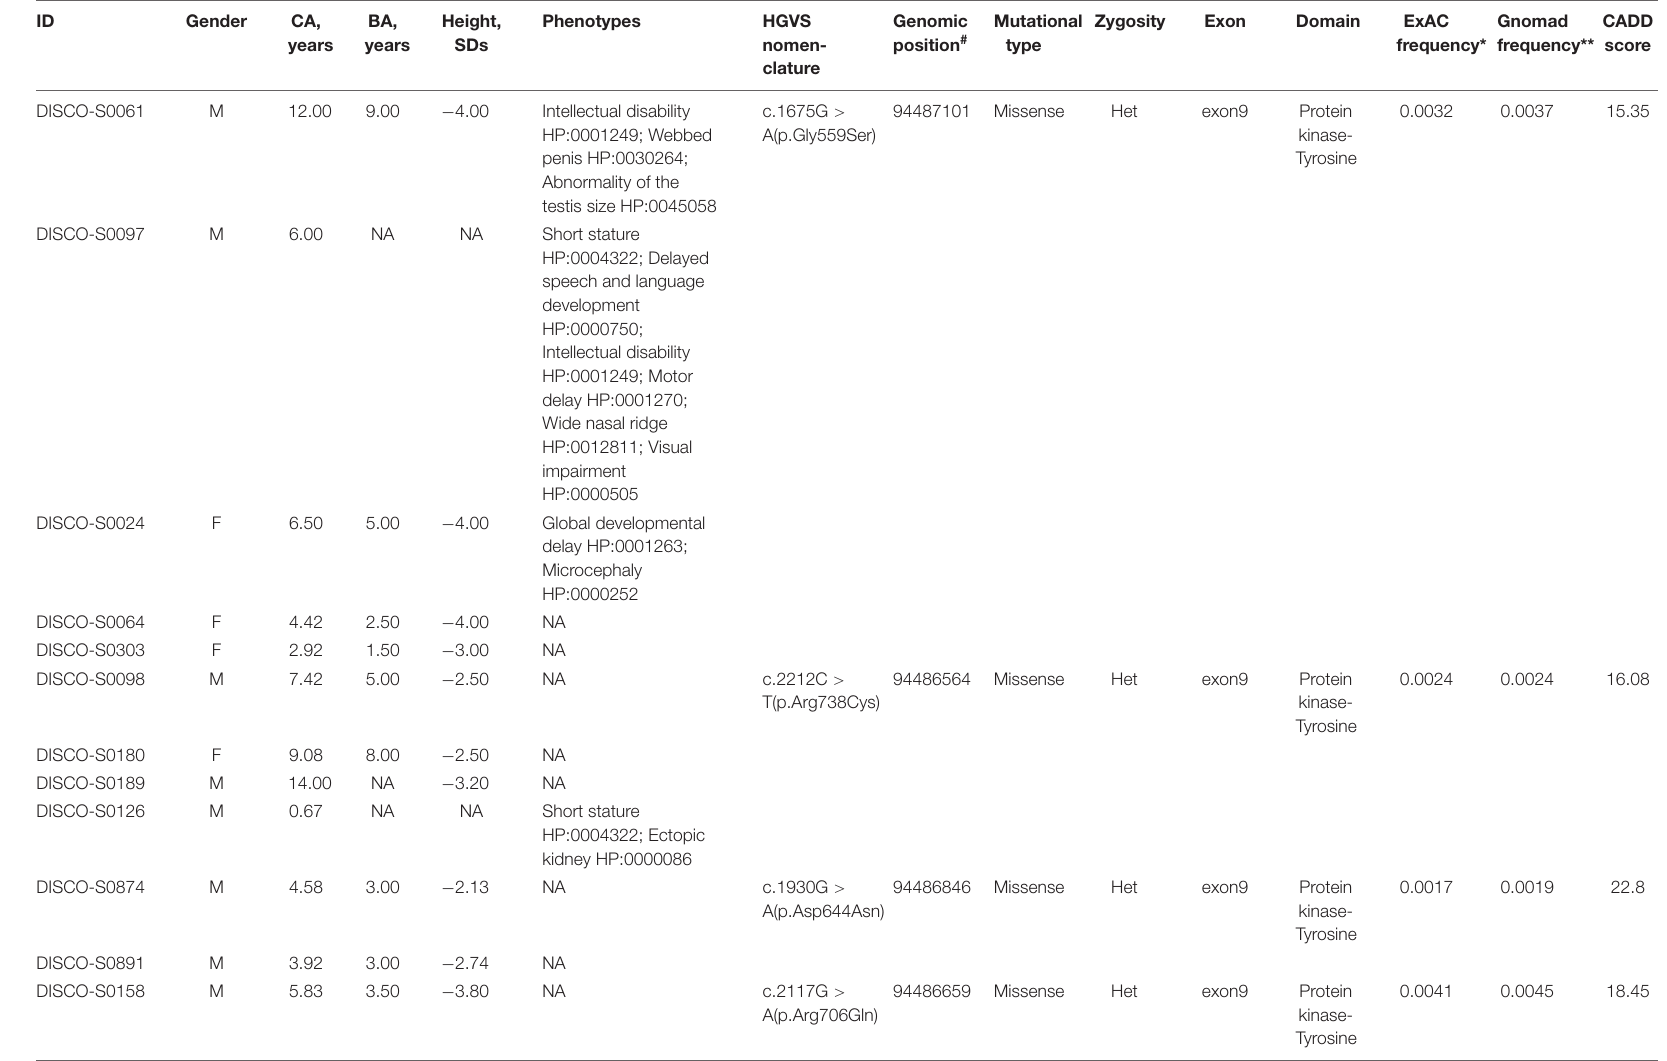
TABLE 1 | Phenotype and genotype of patients carrying mutations in